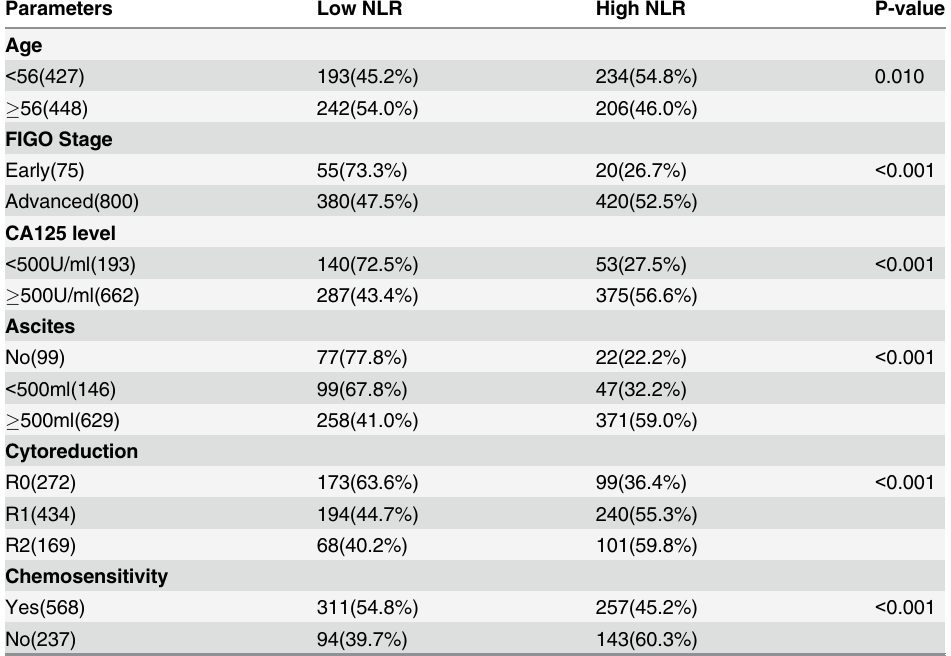
Table 2. Patient clinical parameters and